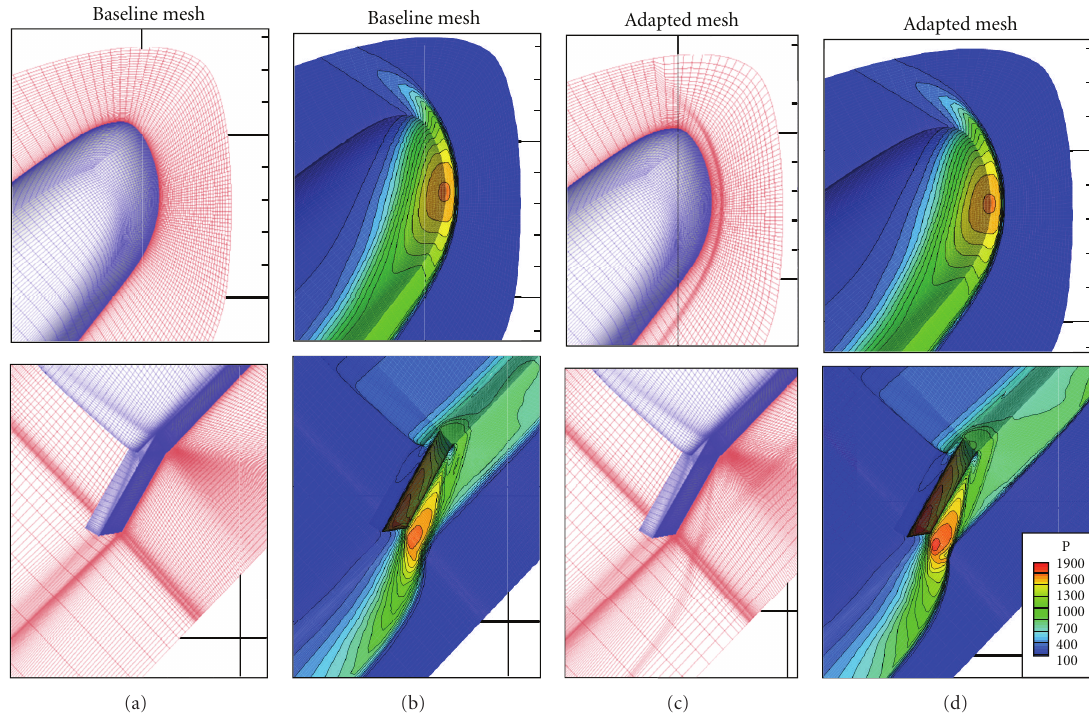
Figure 2: The ESA IXV vehicle: meshes and